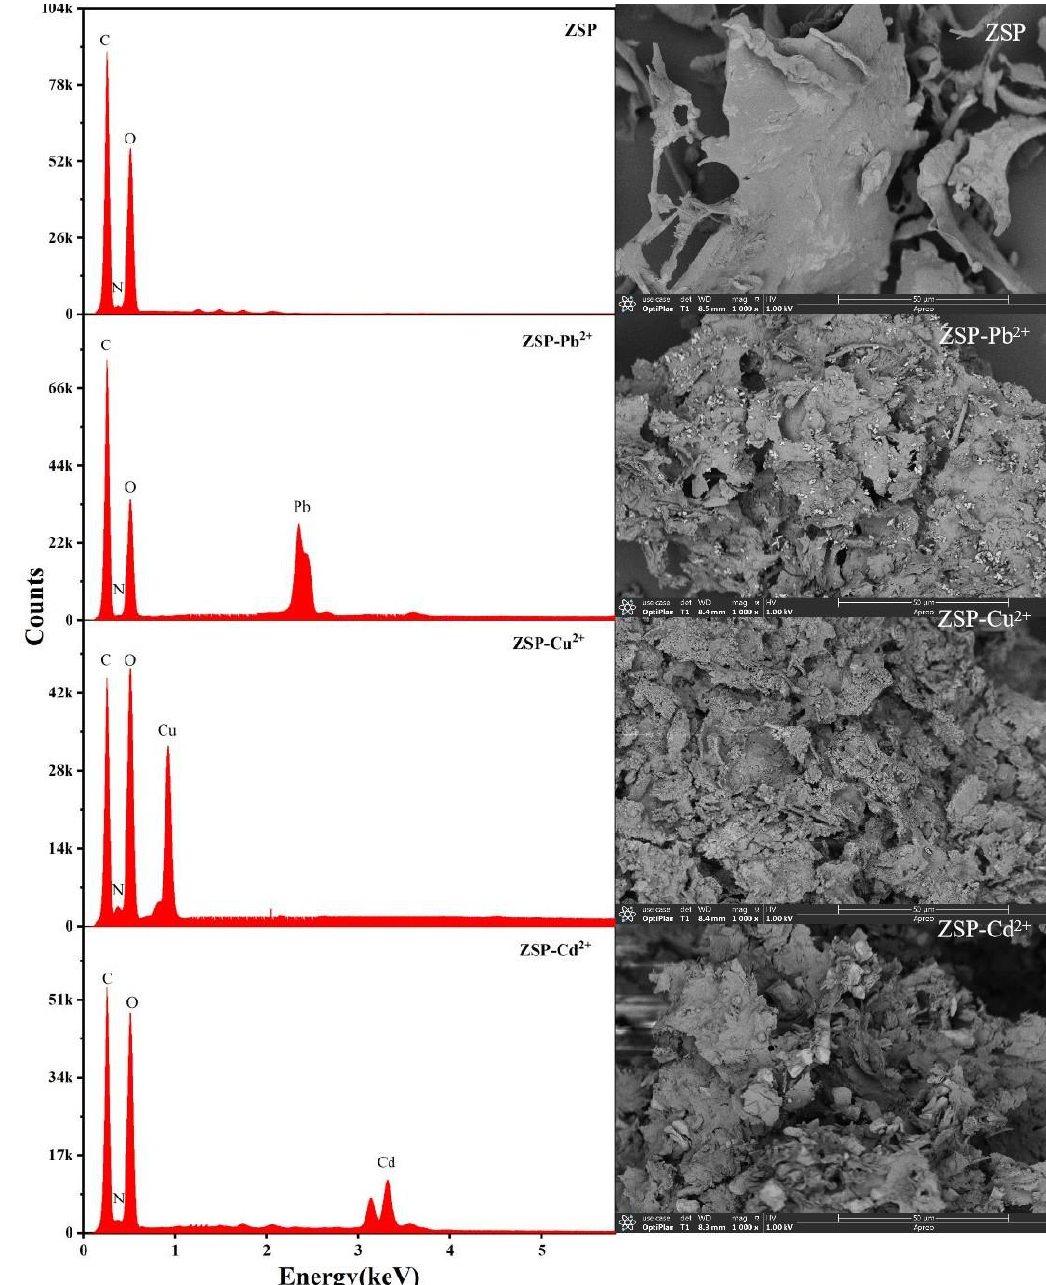
Figure 5. EDX/SEM spectra of before and after the adsorption of Pb 2+ , Cu 2+ and Cd 2+ by